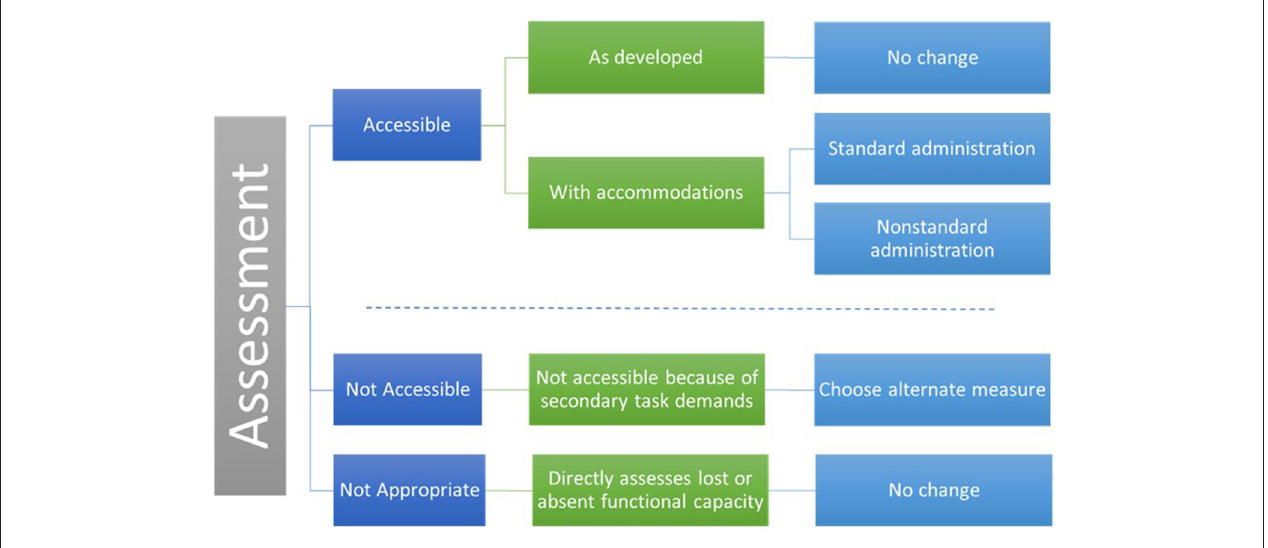
FIGURE 1 | Accessibility categorization of